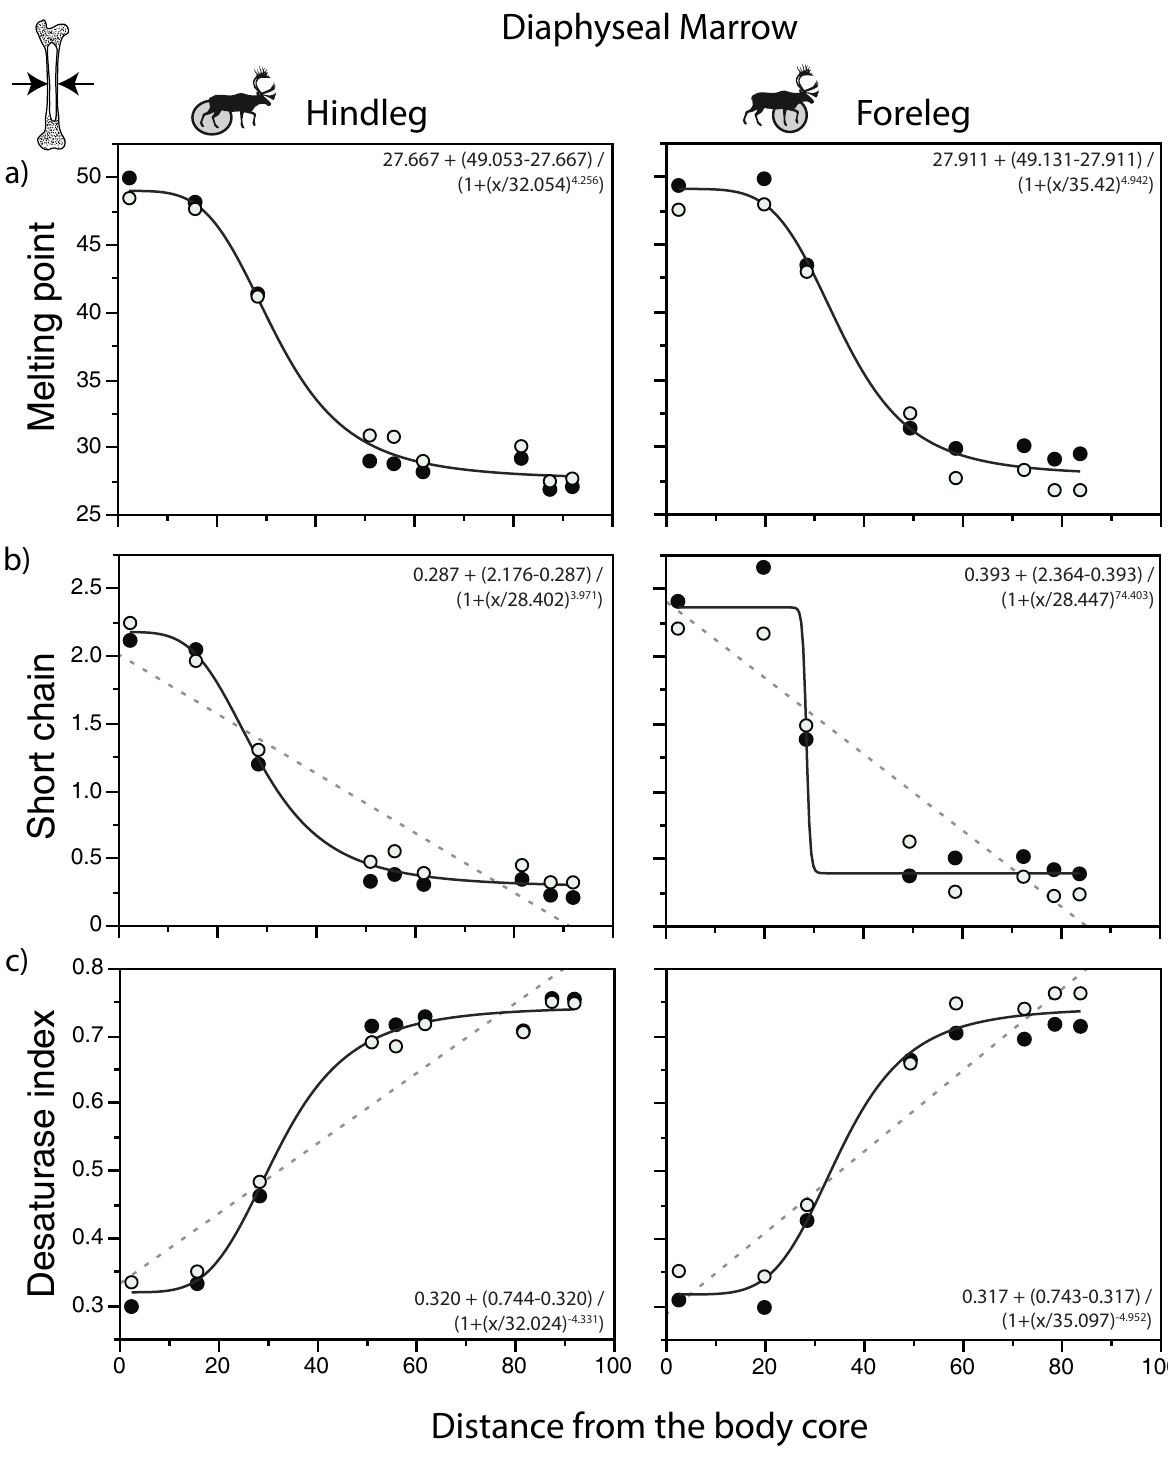
Fig 4. Relationship between fatty acid (FA) parameters and sample distance in the diaphyseal marrow of caribou. a) weighted melting point (in ˚C); b) percentage of short chain saturated FA; c) Δ 9 desaturase index. Bold curves assume a sigmoidal function; dashed curves are relationships that show a better fit with a linear function according to the AICc values (S1 Table). Melting point and FA values calculated as in Fig 3. Distance data from S1 Fig, FA data from Table 2. The regressions were calculated using the mean for the two individuals. Closed circles: individual A; open circles: individual